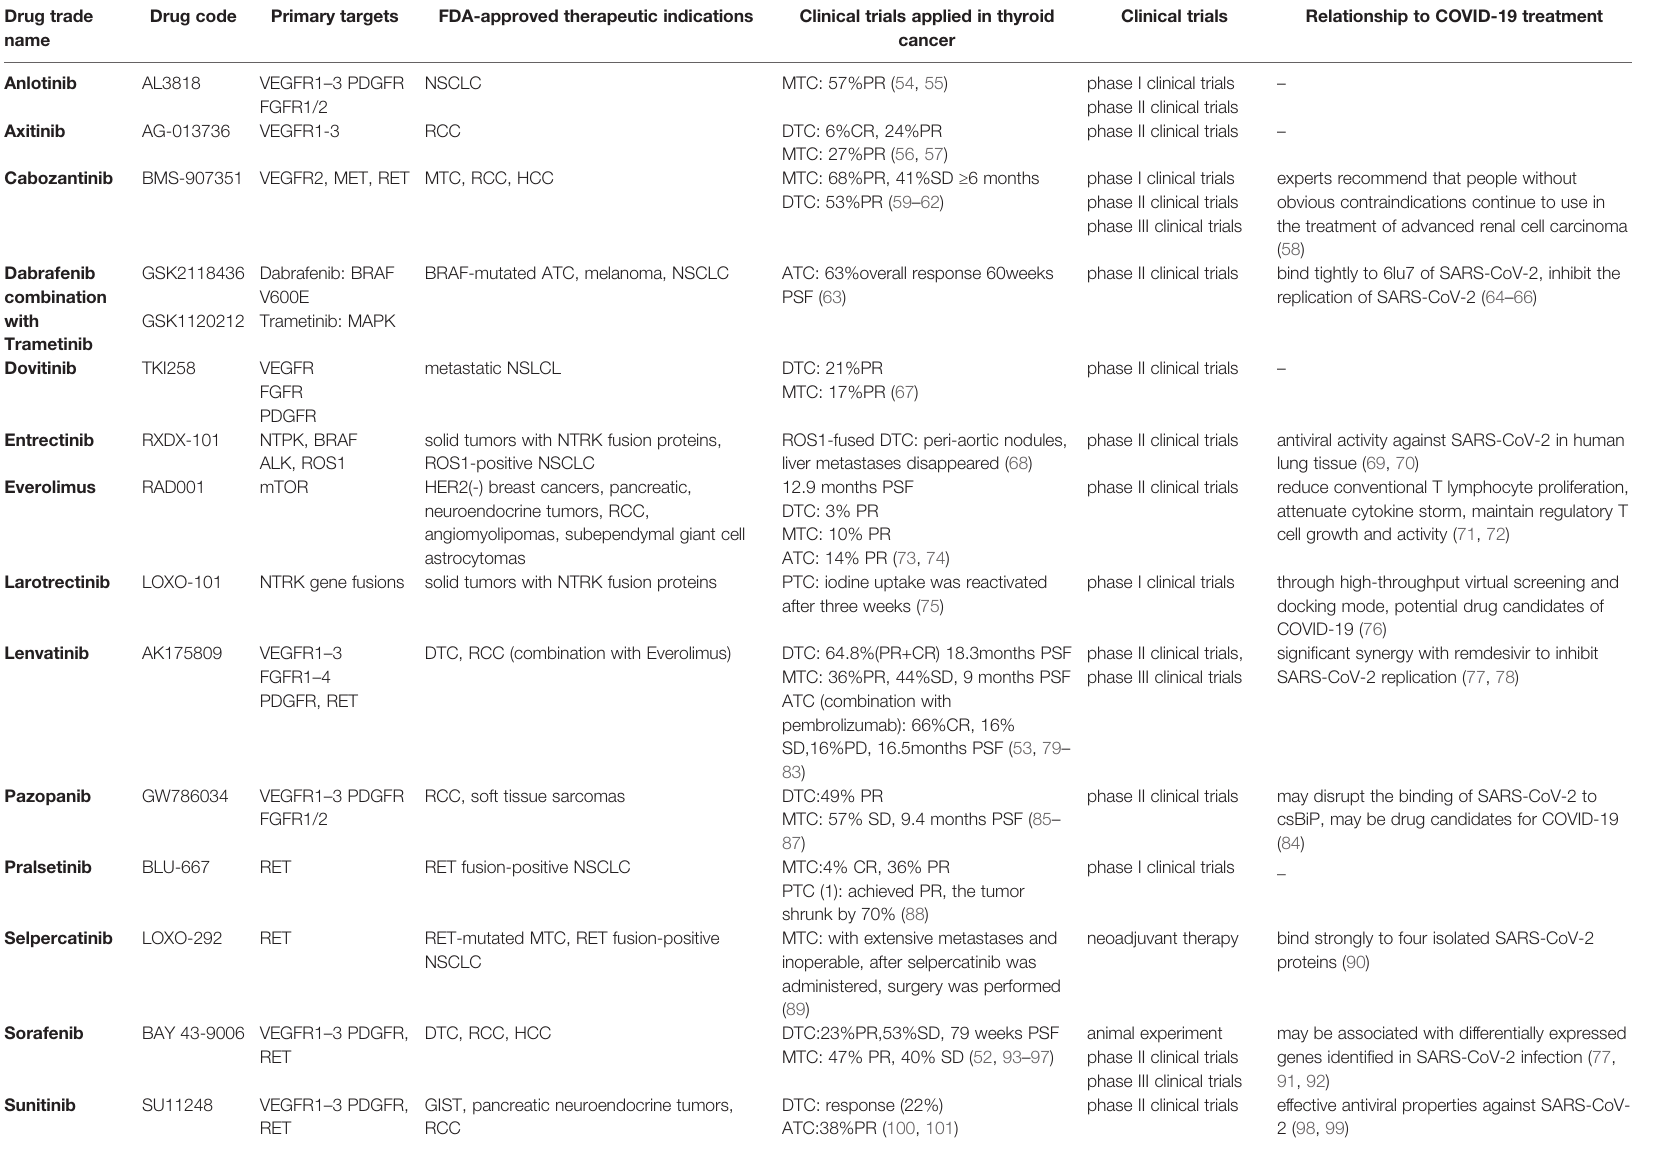
TABLE 2 | Multikinase inhibitors for thyroid cancer during COVID-19